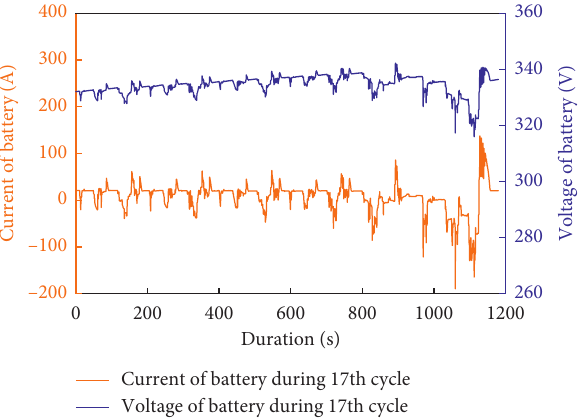
Figure 7: The voltage and current curve of traction battery stack in 17th cycle of the